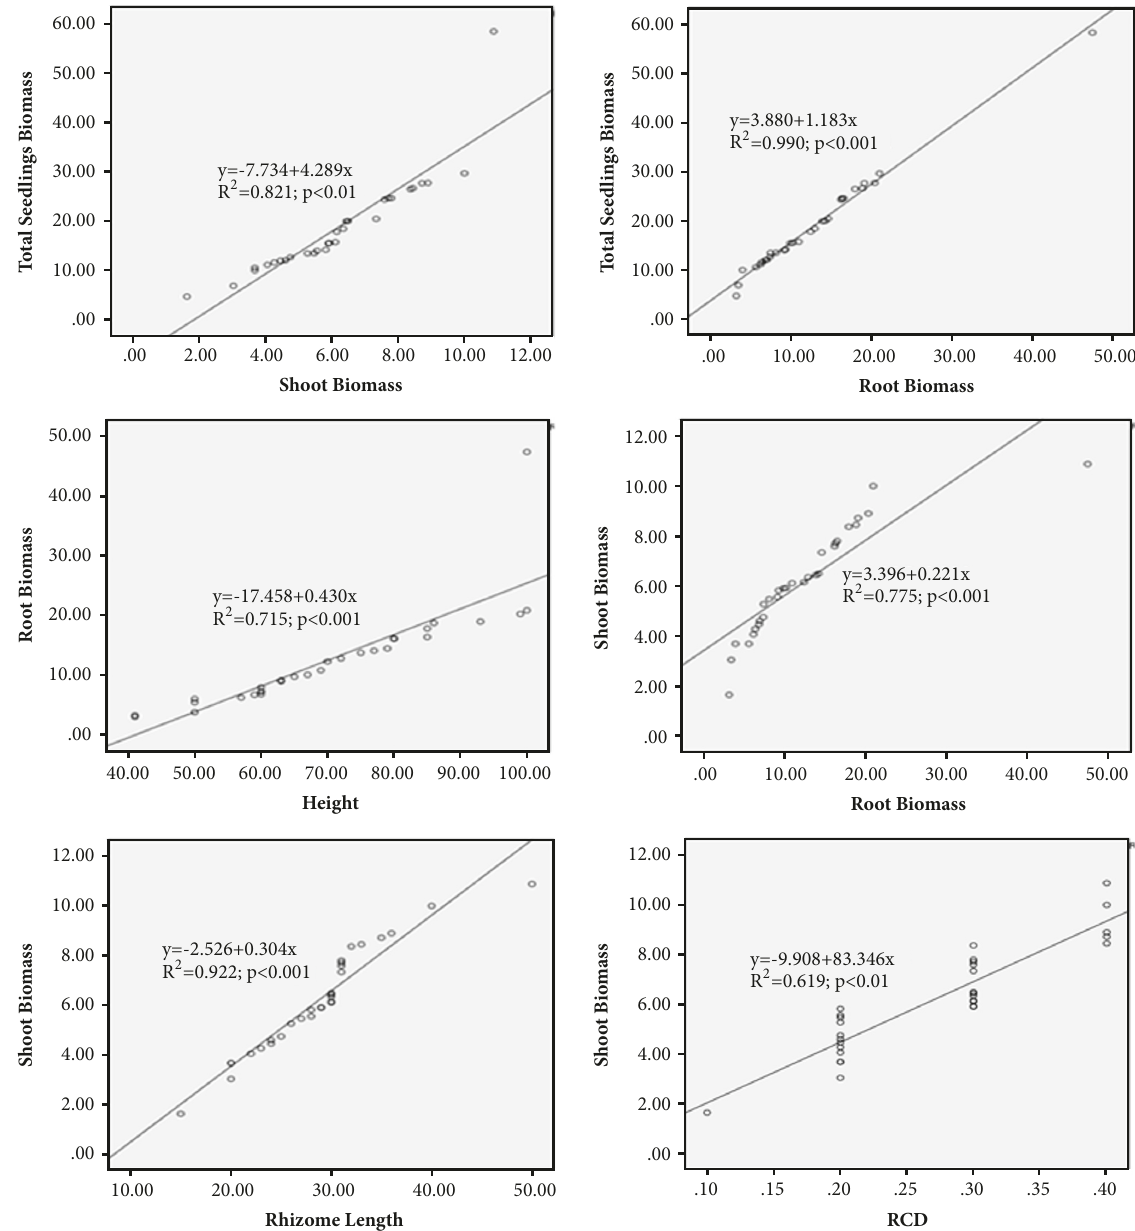
Figure 3: Relationship between O. abyssinica seedlings growth and Biomass variables and the developed linear regression equations and coefficient of determination (R 2 ) that indicated the strength of regression